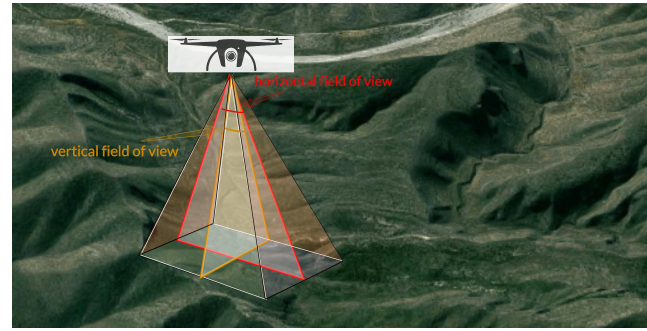
Figure 1. The drone camera’s field of